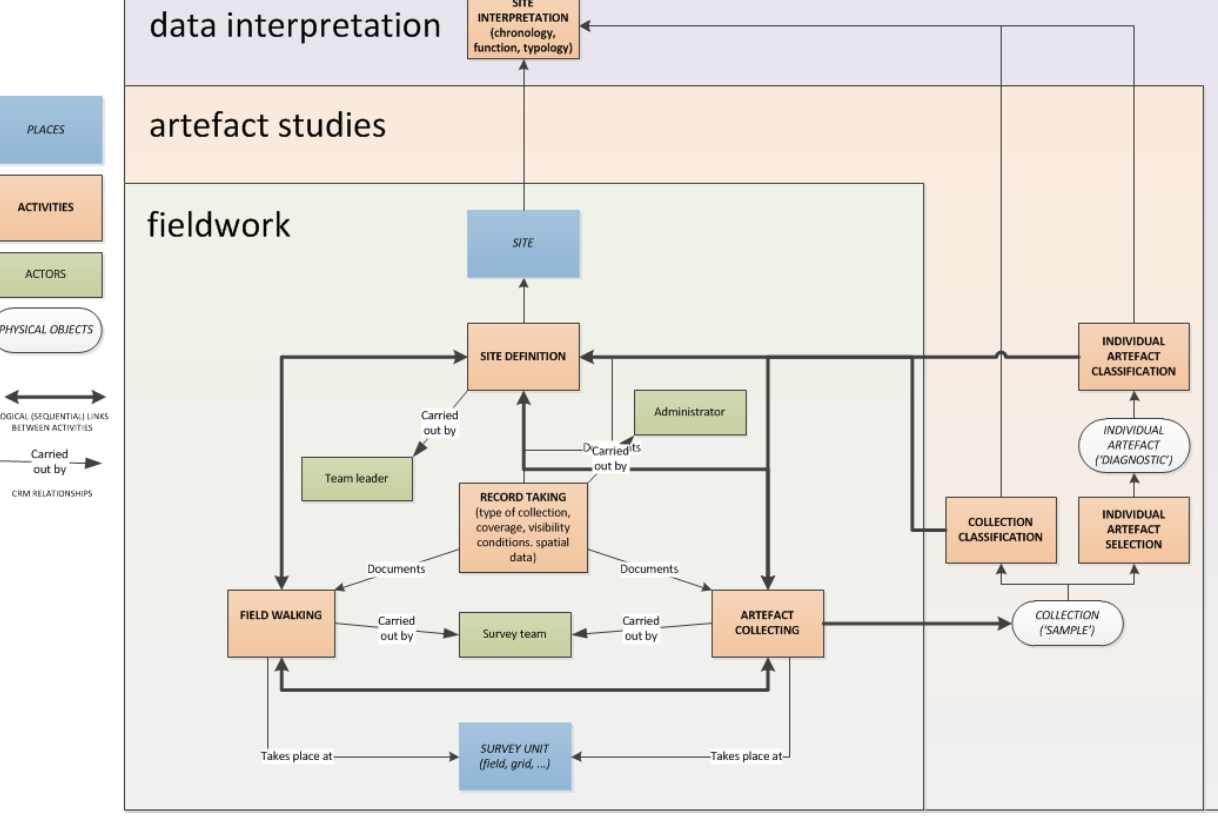
Fig. 4. Schematic rendering of the process of archaeological field